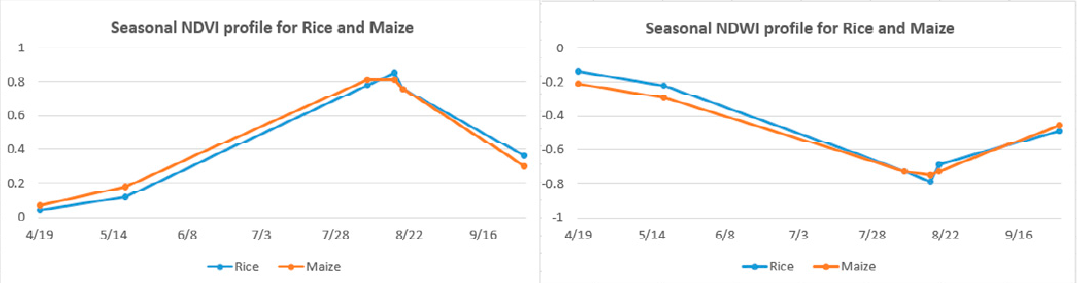
Figure 3. Seasonal Normalized Difference Vegetation Index (NDVI) and Normalized Difference Water Index (NDWI) profiles during the rice and maize growth period.